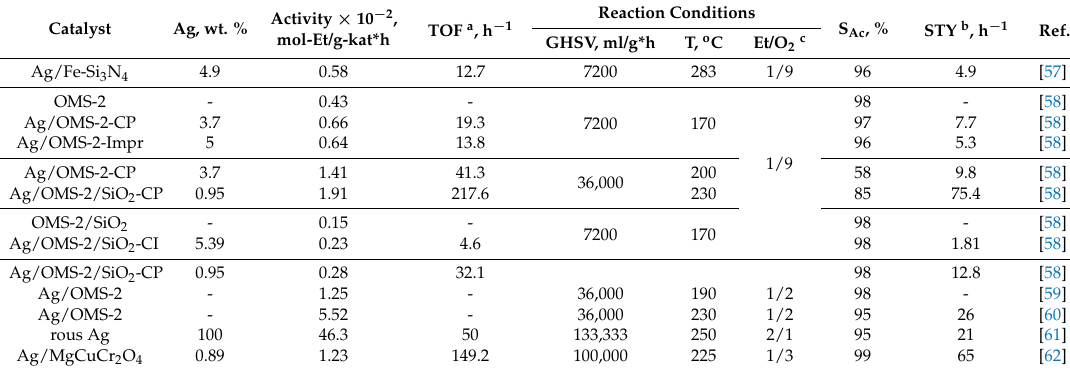
Table 2. Comparison of various Ag-containing catalysts for gas-phase ethanol oxidation. Reprinted with permission from reference [58]. Copyright 2016